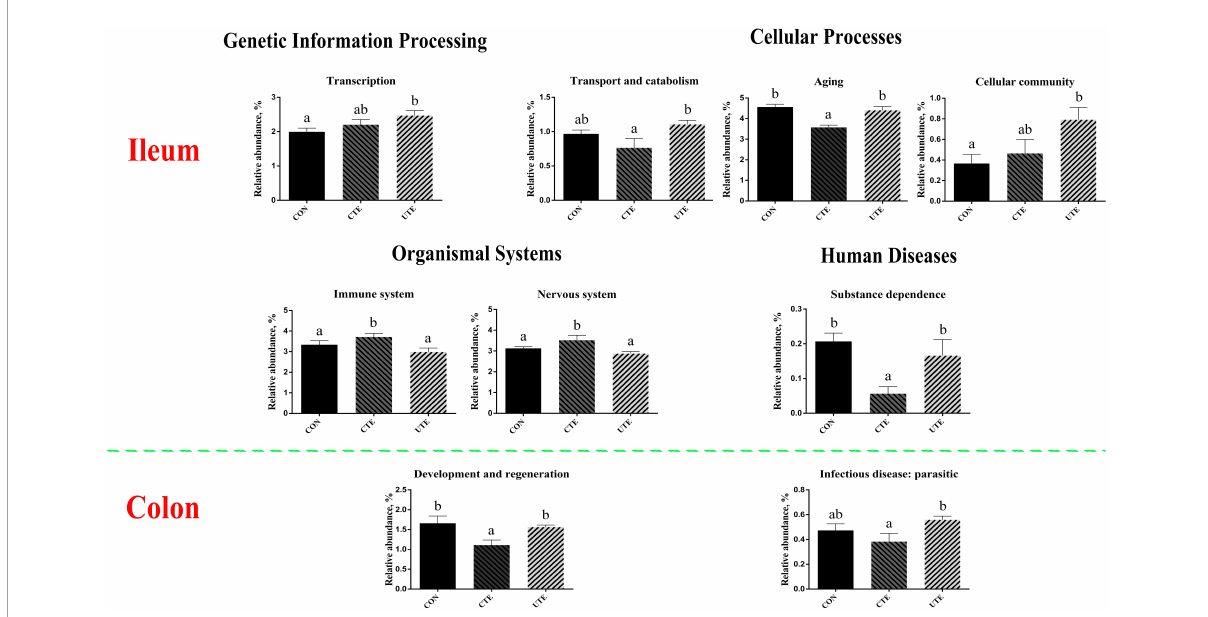
FIGURE8 The prediction of bacterial function based on Kyoto Encyclopedia of Genes and Genomes (KEGG) pathway at level 2. CON, sheep fed with the basal diets; CTE, sheep fed with the basal diets plus 400 mg/kg coated trace elements; UTE, sheep fed with the basal diets plus an equal amount of trace elements in uncoated form. Data are represented as mean and standard error and with different small letter superscripts mean significantly different ( P < 0.05), n =